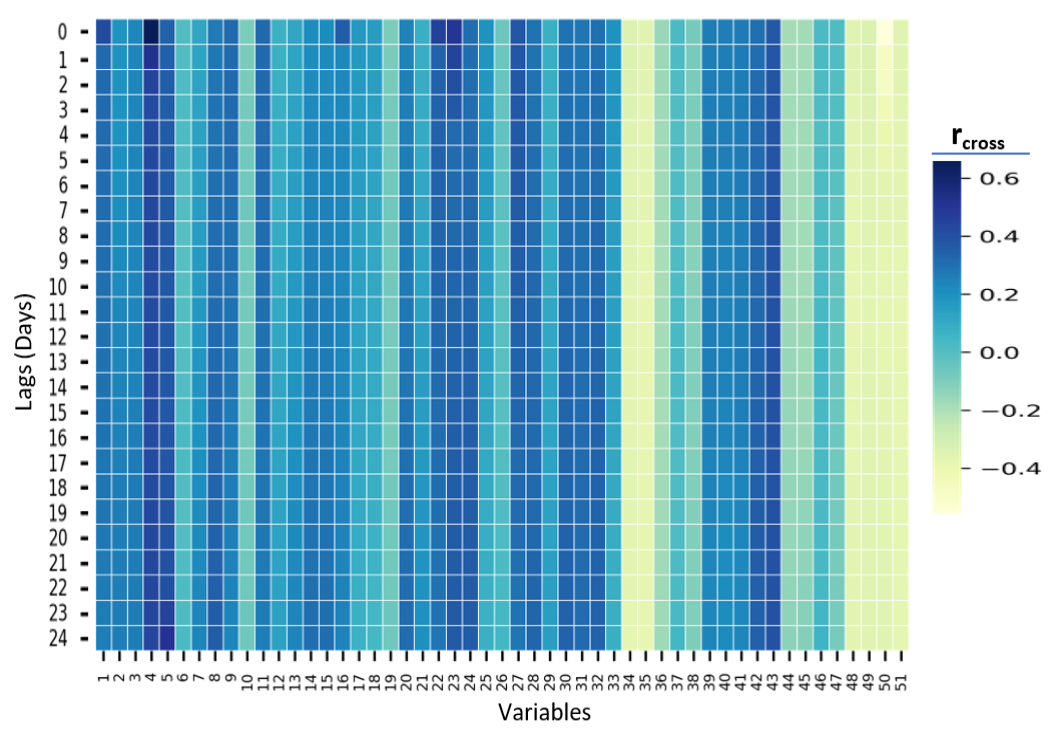
Figure A1. Correlogram showing the covariance between the objective variable (MSL) and the predictor variables in terms of the cross-correlation coefficient ( r cross ) for Fiji Islands for the lags between 0 and 24.